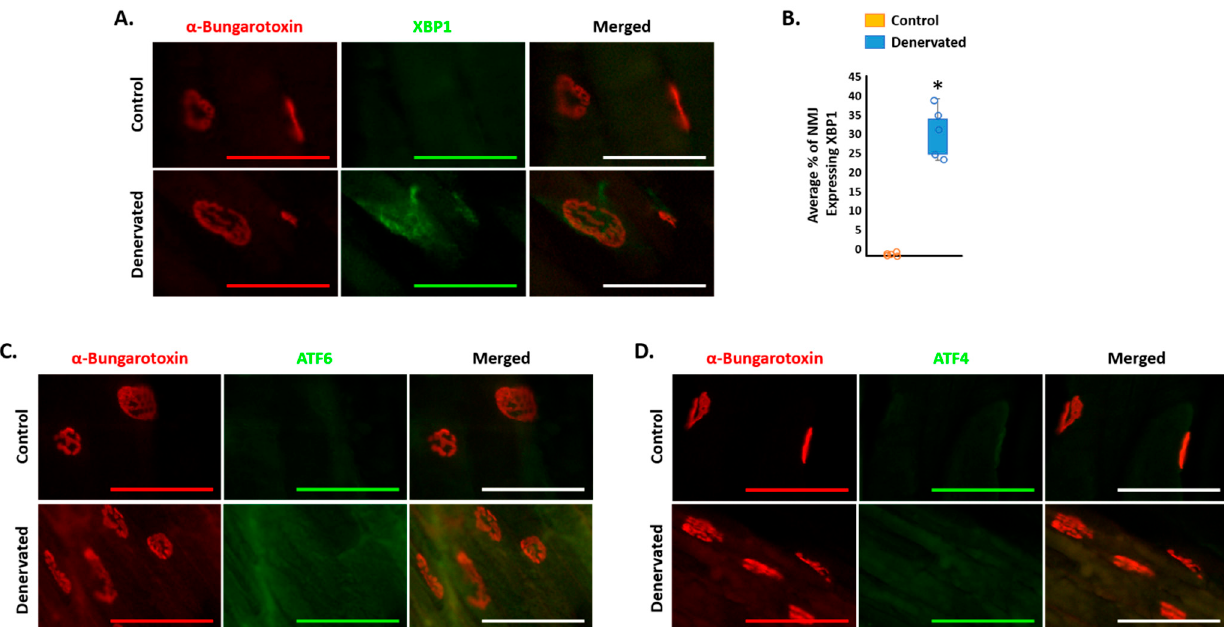
Figure 4. Effect of transection of the sciatic nerve on expression of the unfolded protein response (UPR) in the neuromuscular junction (NMJ). ( A ) Representative images of the control and denervated GAS muscles immunostained against XBP1 and with a snake toxin that has a high affinity for AChRs ( α -bungarotoxin-tetramethylrhodamine). Scale bar = 100 μ m. ( B ) Average percentage of NMJ expressing XBP1 in control and denervated muscle. N = 6/group. ( C ) Representative images of the control and denervated GAS muscles immunostained against ATF6 and with a snake toxin that has a high affinity for AChRs ( α -bungarotoxin-tetramethylrhodamine). Scale bar = 100 μ m. ( D ) Representative images of the control and denervated GAS muscles immunostained against ATF4 and with a snake toxin that has a high affinity for AChRs ( α -bungarotoxin-tetramethylrhodamine). Scale bar = 100 μ m. * p < 0.05, values significantly different from the control mice by a paired two-tailed t -test.